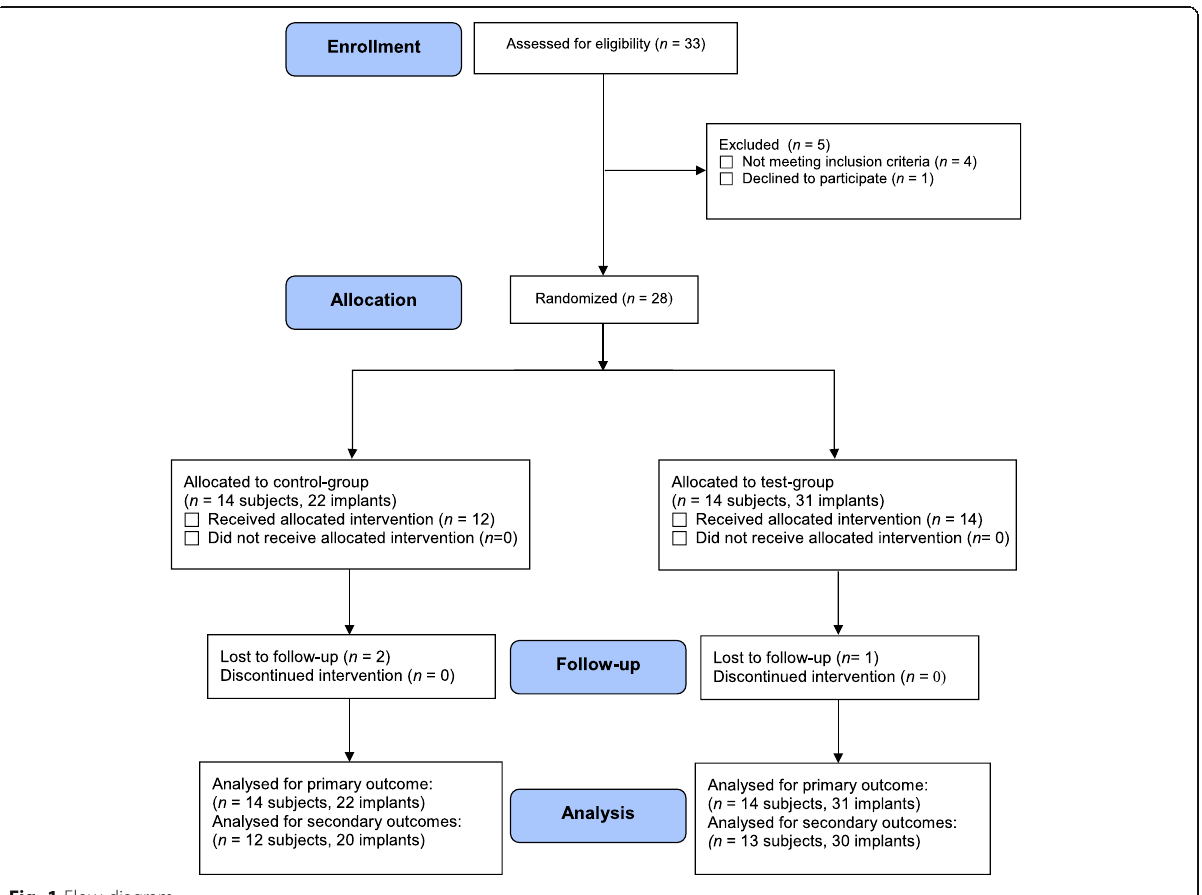
Clinical outcomes Descriptive statistics of the clinical outcomes at baseline